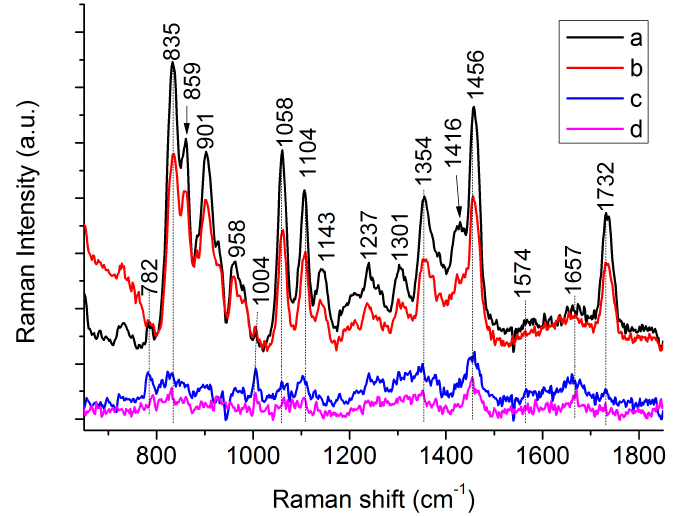
Figure 1. Single-cell Raman spectra from Cupriavidus necator H16 cells cultured for 24 h (a,b) or 2 h (c,d). Spectra were acquired from cells while trapped (a,c) or adhered onto quartz cover (b,d) by laser tweezers Raman spectroscopy (LTRS). Curves c and d were amplified by factor of two.